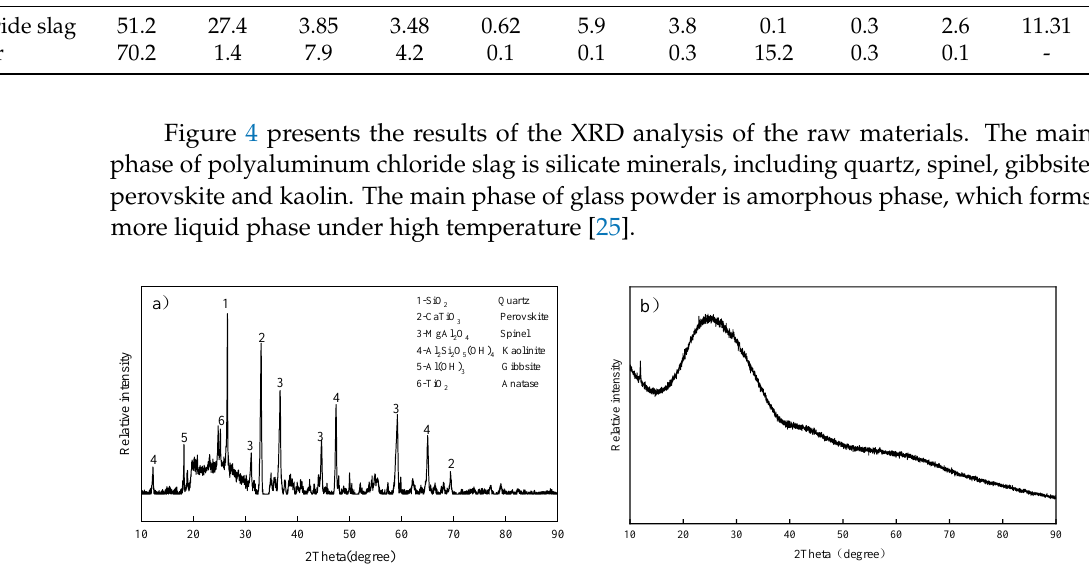
Table 1. The chemical composition of raw materials (wt/%). Samples